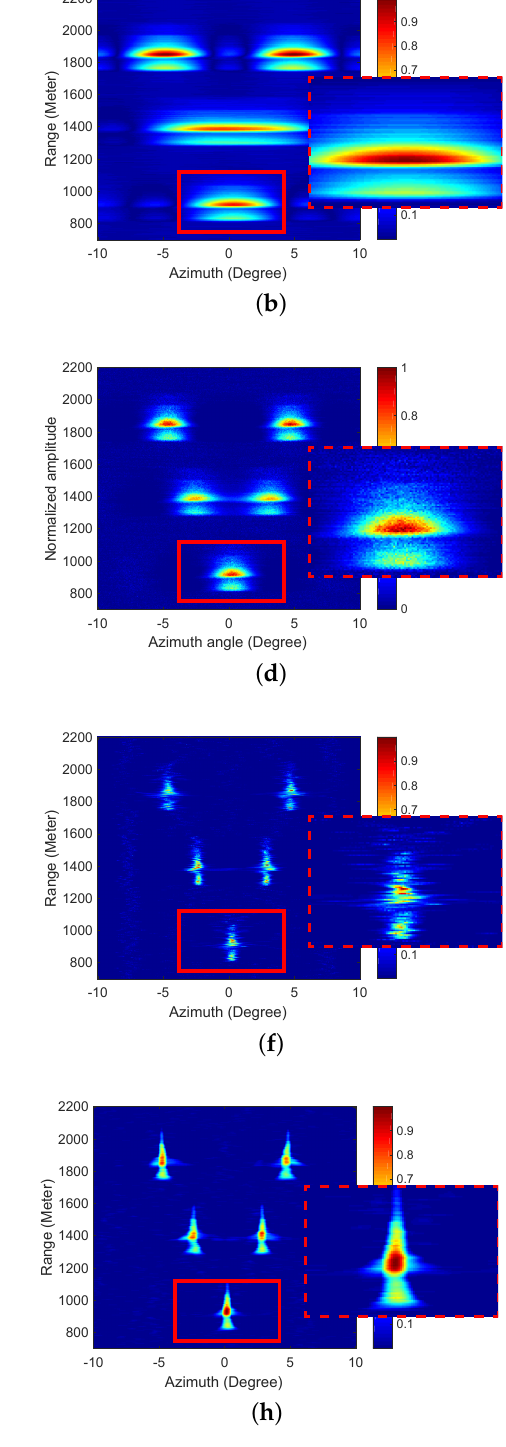
Figure 6. Area targets simulation results with the SNR of 10 dB. ( a ) Real-aperture echo. ( b ) Result processed by TSVDM. ( c ) Result processed by FTVM. ( d ) Result processed by MLE. ( e ) Result processed by IAA. ( f ) Result processed by MAPE. ( g ) Result processed by SSM. ( h ) Result processed by